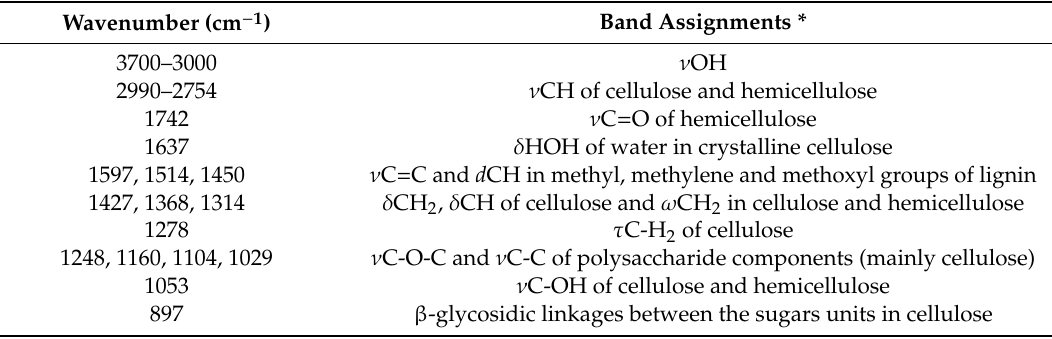
Table 1. Assignment of the main ATR-FTIR bands of flax fibers